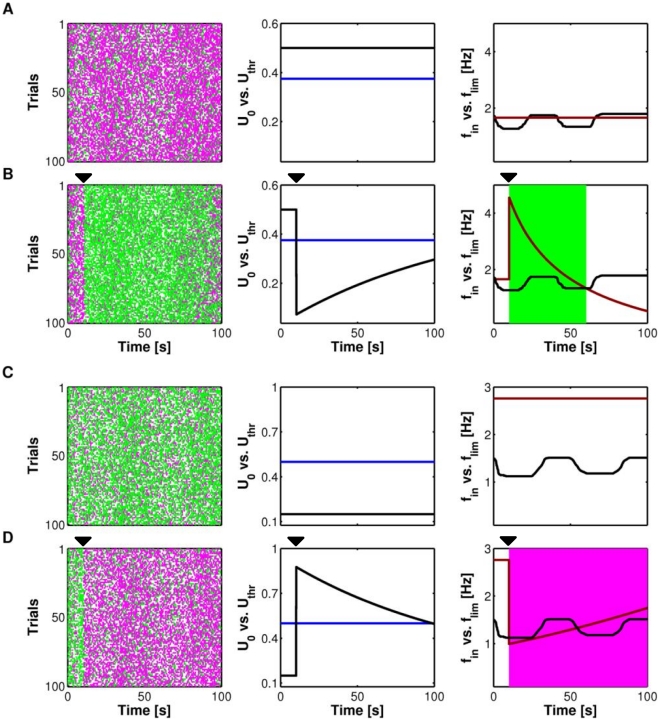
Astrocytic glutamate regulates transitions between facilitation and depression at the same synapse.(A,B, left) Raster plots of a depressing synapse, without (A) and in presence of (B) a single event of glutamate exocytosis from the astrocyte (onset at the black mark at t = 1 s, α = 0) for n = 100 Poisson spike trains with the same average frequency fin (black line in A,B, right). A green dot marks an input spike that released more resources than its preceding one, while a magenta dot represents an input spike that released less resources than its previous one. (A,B, middle) The increase of facilitated spike pairs by release-decreasing astrocytic glutamate on the depressing synapse is due to the decrease of synaptic basal release probability U
0 (black line) beyond the switching threshold U
thr (blue line) while the limiting frequency (f
lim, dark red line) increase above the average input frequency (f
in, black line). In such situation in fact, both conditions needed for short-term facilitation are fulfilled (see “Mechanisms of short-term presynaptic plasticity” in “Methods”). (C, D) The opposite occurs for a facilitating synapse under the effect of a release-increasing astrocyte (α = 1). In this case in fact, astrocytic glutamate makes U
0 increase beyond U
thr (D, middle) while f
lim switches from above to below f
in, thus marking onset of depression (D, right). The same results can alternatively be obtained analyzing the slope of the  curve (equation 3) for f
in(t) (Figure S9). Parameters as in Table S1.